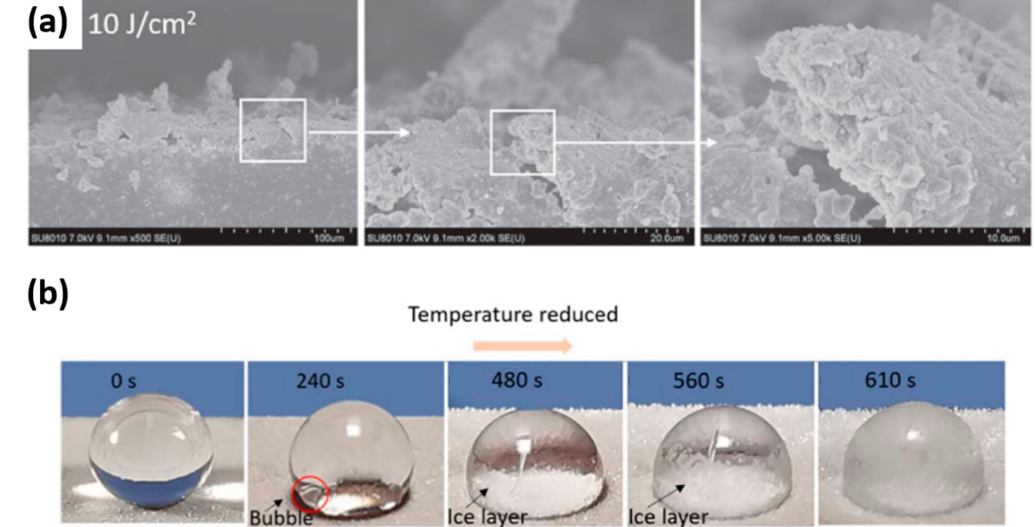
Figure 10. ( a ) Morphology of samples irradiated with laser fluences of 10 J cm − 2 . ( b ) Freezing of the water droplet set on the superhydrophobic silicone rubber surface (laser fluences 12.5 J cm − 2 ). In the red circle a bubble squeezed into the water droplet during the process is highlithed, Adapted from [115] ( © IOP Publishing. Reproduced with permission. All rights reserved).